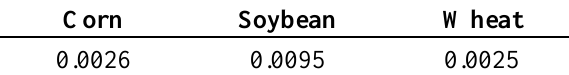
Table 4. Plant P uptake